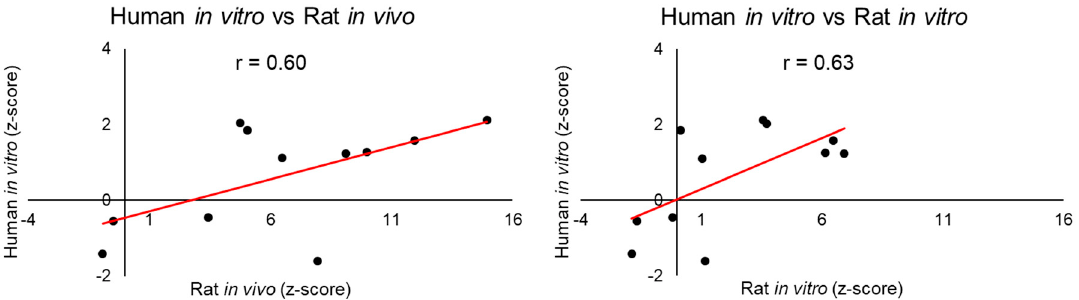
Figure 4. Pearson’s correlation ( r ) between liver-injury modules activated in rat and human hepatocytes after 24 h of high-dose treatment with thioacetamide-S-oxide (in vitro) or thioacetamide (in vivo).